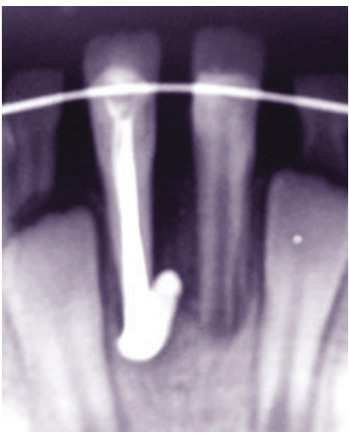
Figure 7: Twelve-month follow-up radiograph; continued root for- mation is detectable.